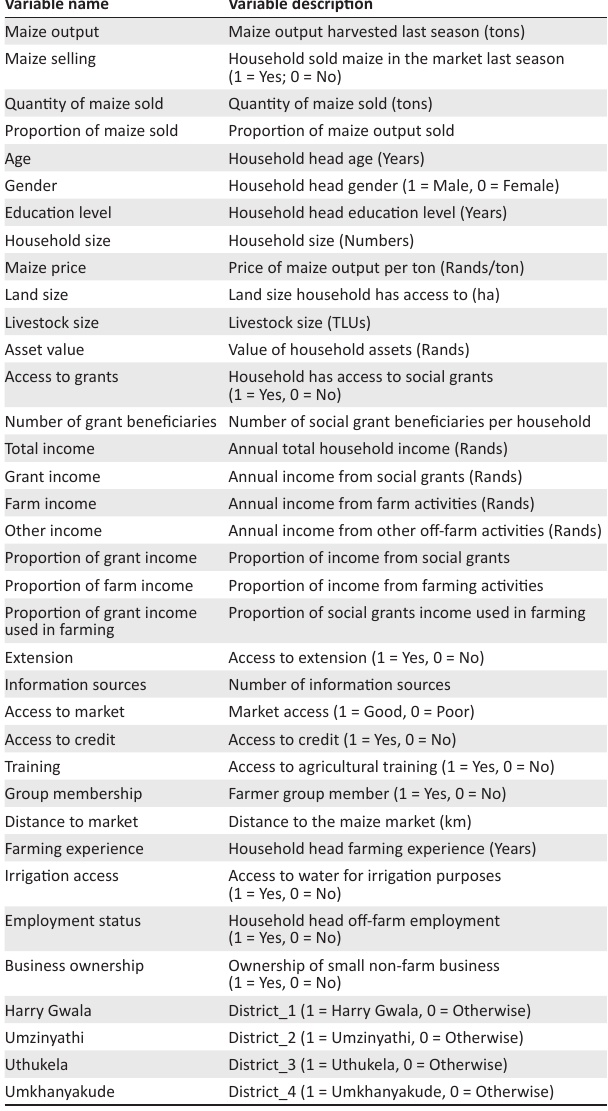
TABLE 1: Variables